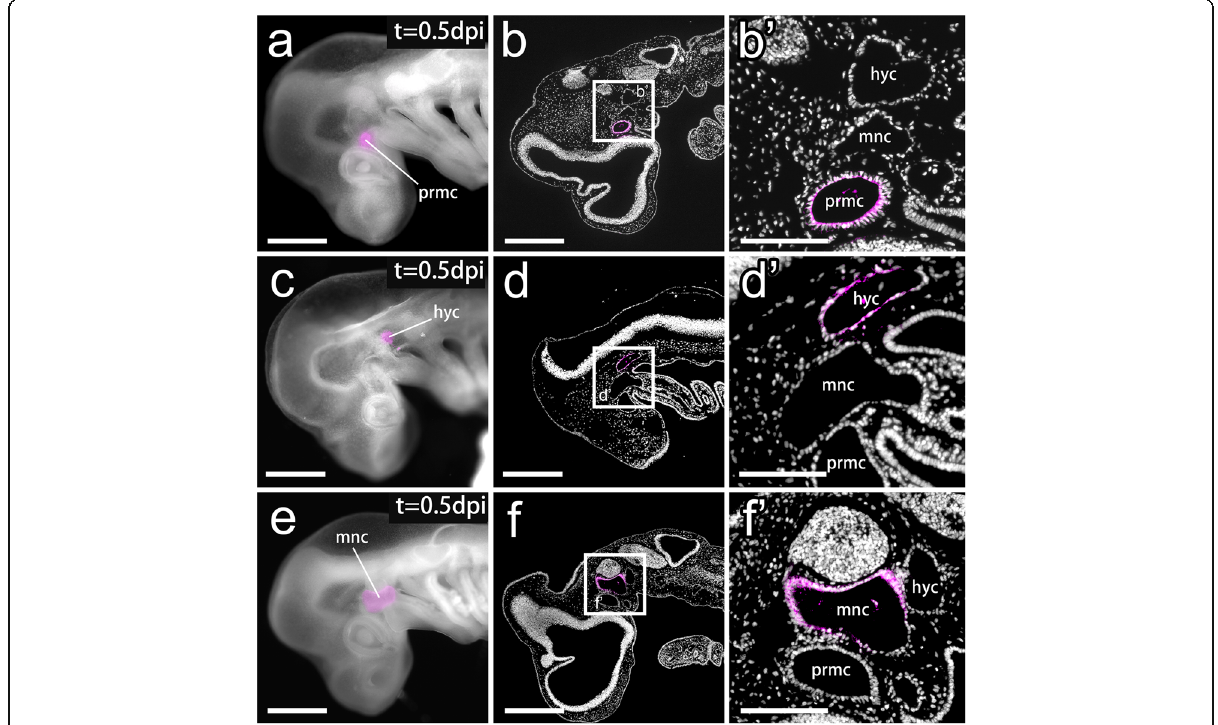
Fig. 2 DiI-labeled head cavities at the pharyngula stage. a-b ′ An embryo with DiI injected into the prmc at st. 25. a Left lateral view of the DiI- injected embryo at 0.5 days postinjection (dpi). b-b ′ A sagittal section of ( a ) and a magnified image in the inset ( b ′ ) showing DiI-labeled cells (magenta) found specifically in the epithelial wall of the prmc. c-d ′ An embryo with DiI injection into the hyc at st. 25. c Left lateral view of the DiI-injected embryo at 0.5 dpi. ( d-d ′ ) A sagittal section of ( c ) and a magnified image in the inset ( d ′ ) show DiI-labeled cells (magenta) found specifically in the epithelial wall of the hyc. e-f ′ An embryo with DiI injection into the mnc at st. 25. e Left lateral view of a DiI-injected embryo at 0.5 dpi. f-f ′ A sagittal section of ( e ) and a magnified image in the inset ( f ′ ) show DiI-labeled cells (magenta) found specifically in the epithelial wall of the mnc. Panels b , b ′ , d , d ′ , f , and f ′ show sections counterstained with DAPI (gray). hyc, hyoid head cavity; mnc, mandibular head cavity; prmc, premandibular head cavity. Scale bars = 500 μ m ( a , b , c , d , e , and f ), 200 μ m ( b ′ , d ′ , and f ′